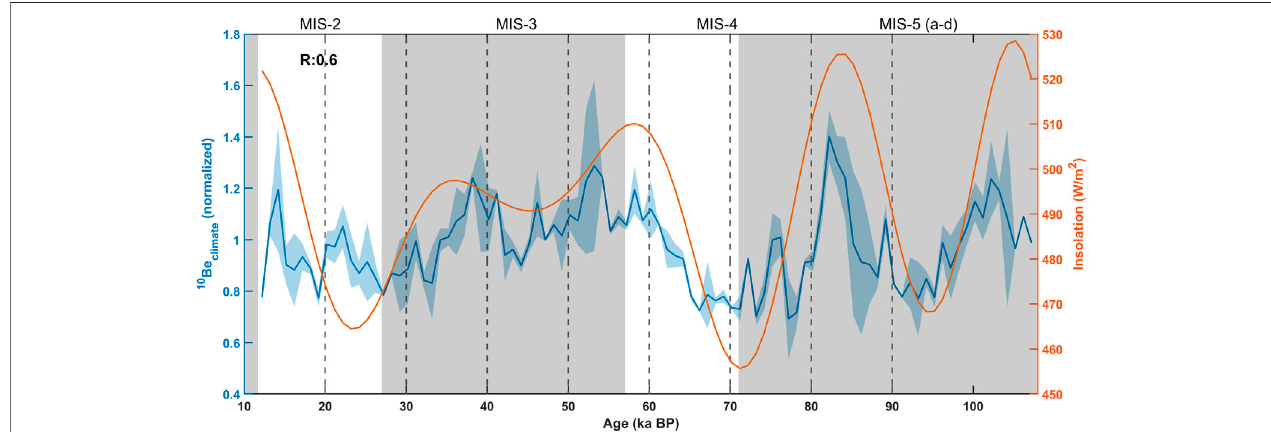
FIGURE 3 | Stack 10 Be record based on NEEM and GRIP 10 Be fl ux climate records showing variability comparable to the summer insolation (TOA) at 65 ° N at a periodicity of 21 ° ka. The shaded area represents a 2-standard deviation error. The R in bold indicates the signi fi cant value ( p < 0.01, student t-test adjusted by the autocorrelation following (Hu et al.,